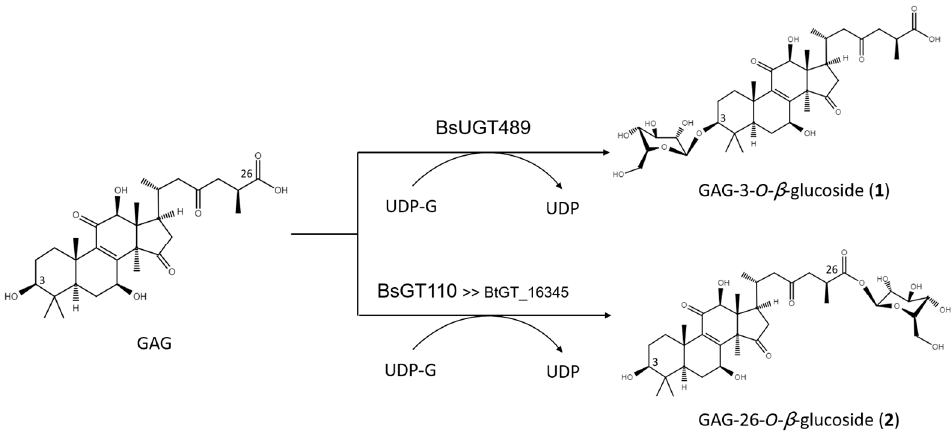
Figure 4. The biotransformation process of GAG to GAG saponins by the Bacillus